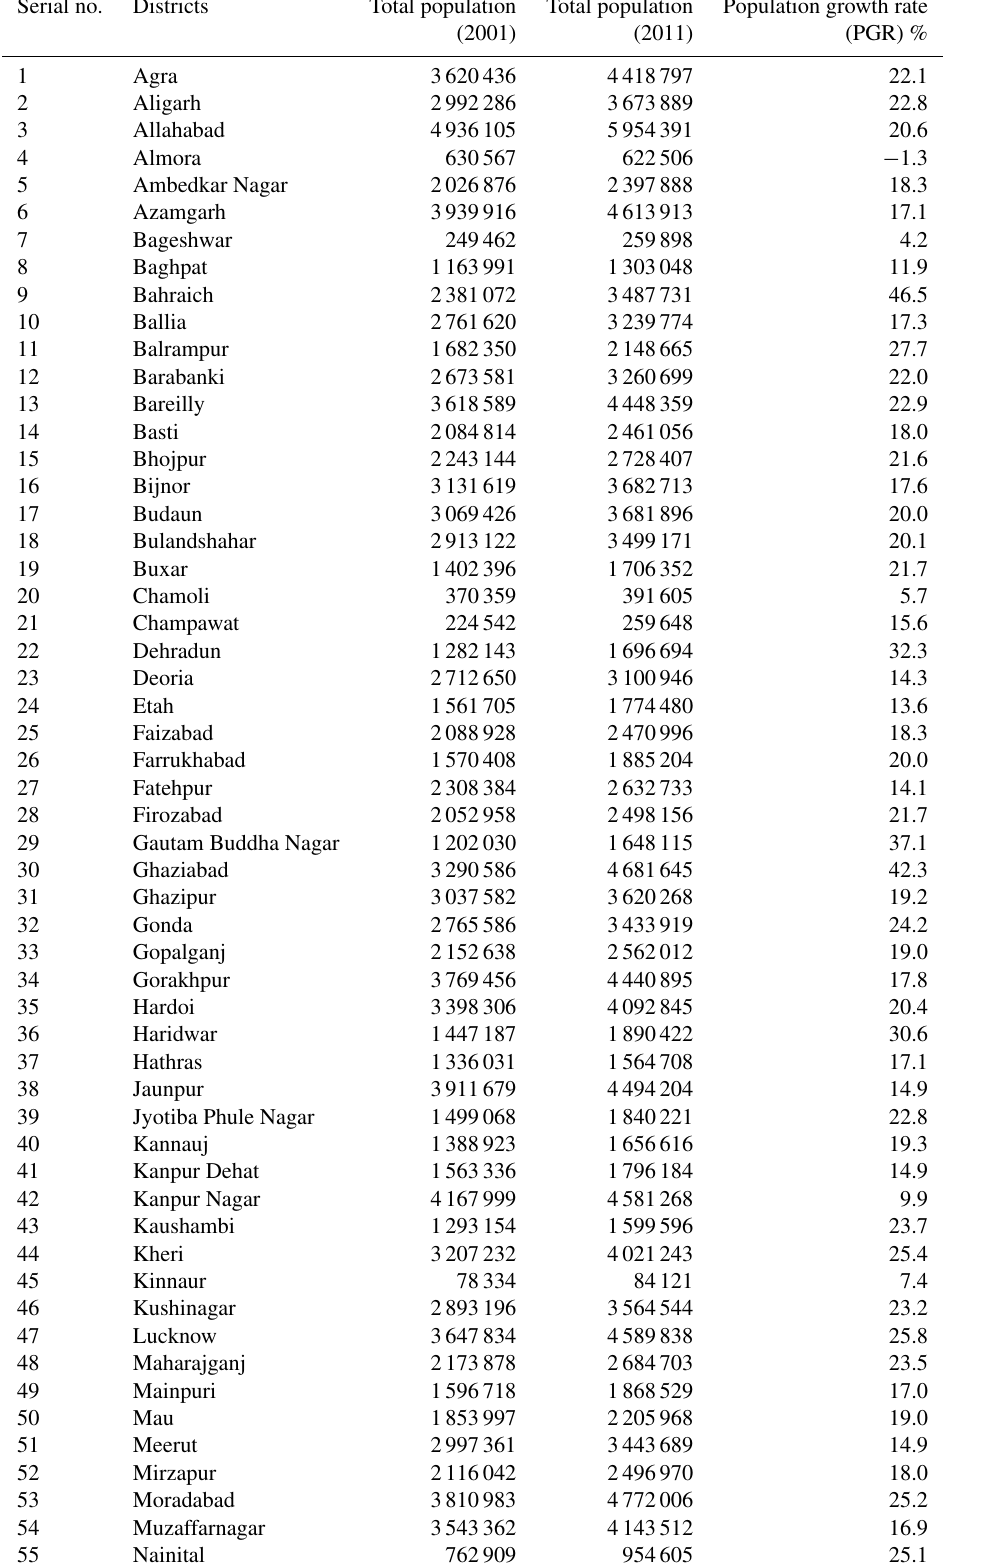
Table 3. Table showing total population and population growth rate (PGR) in percentage in the census years 2001 and 2011. Serial